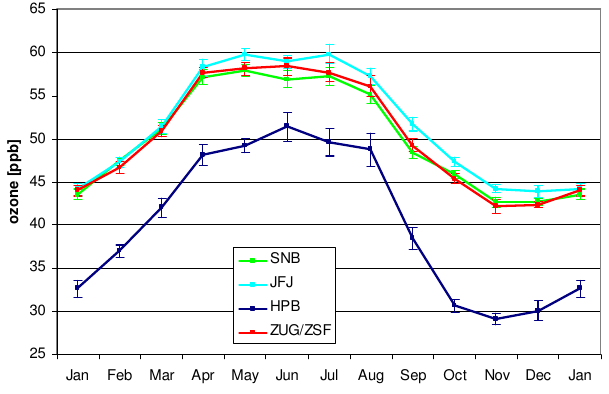
Fig. 2. O 3 time series at the respective “DACH” sites since 1995; blue: HPB; red: ZUG/ZSF, light blue: JFJ, green: SNB. Monthly Figure 2. O3 time series at the respective „DACH“ sites since 1995; blue: HPB; red: 4 mean mixing ratios (solid) and linear trend (dashed). Figure.3. O ZUG/ZSF, light blue: JFJ, green: SNB. Monthly mean mixing ratios (solid) and linear trend 5 (dashed). 6